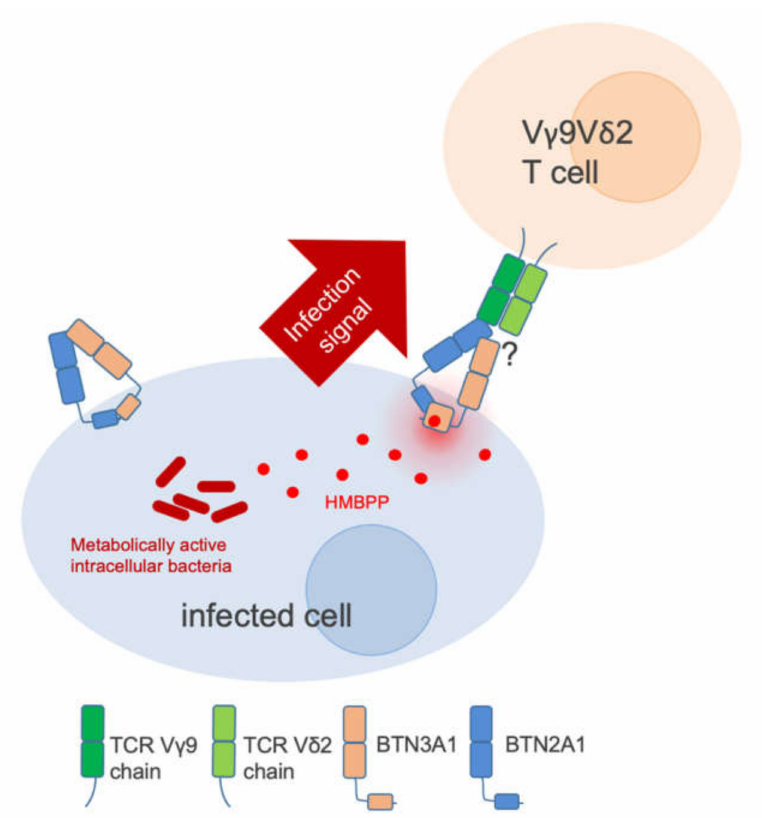
Figure 1. Butyrophilin 3 family member A1 (BTN3A1) is a pathogen-associated molecular pattern (PAMP) receptor. HMBPP from metabolically active bacteria, leaks into the cytoplasm where it is detected by the intracellular B30.2 domain of BTN3A1, triggering a conformational change within the protein. Thereby, the intracellular infection signal is transmitted through the plasma membrane to the surface, where BTN3A1 is constitutively associated with the Butyrophilin family member BTN2A1. Together they form an immunological synapse in which BTN2A1 interacts with the V γ 9 chain of the V γ 9V δ 2